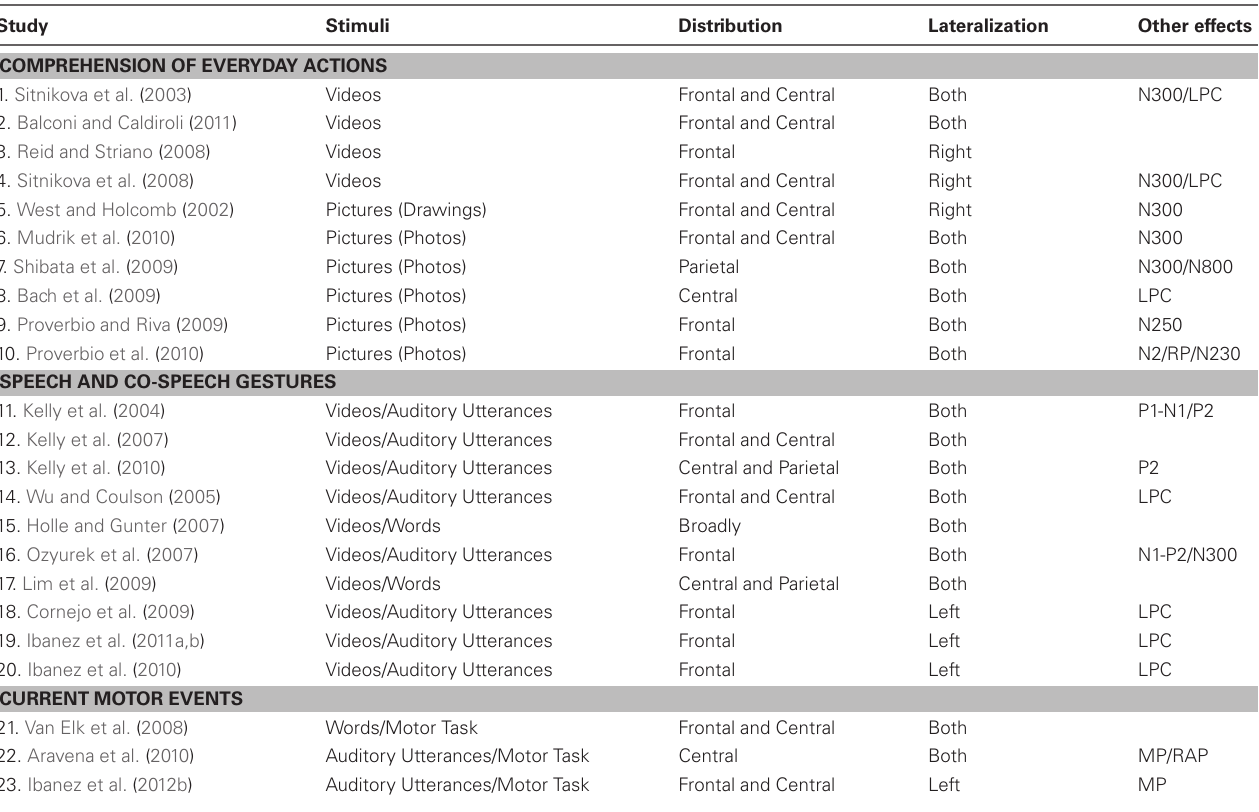
Table 1 | A summary of the reviewed studies on N400 for action